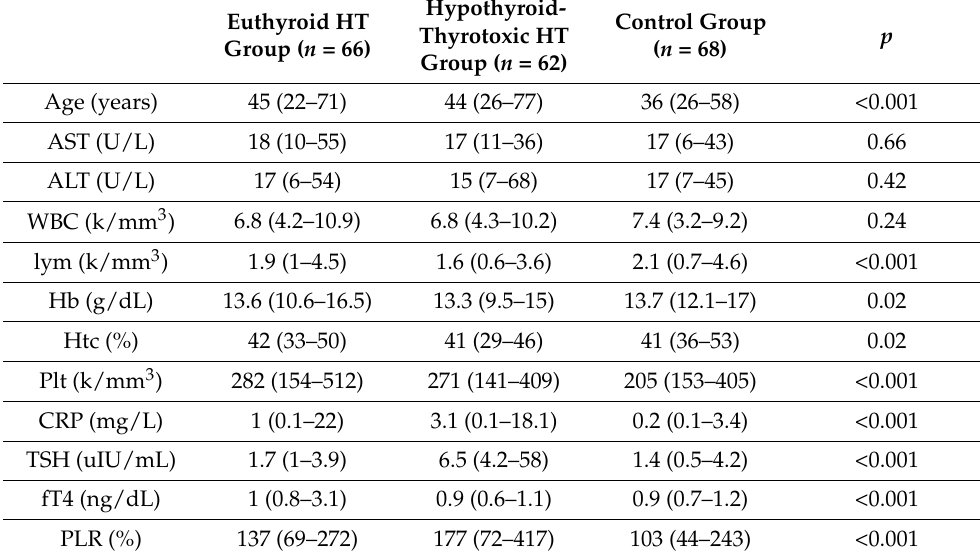
Table 1. Laboratory data of the study cohort.